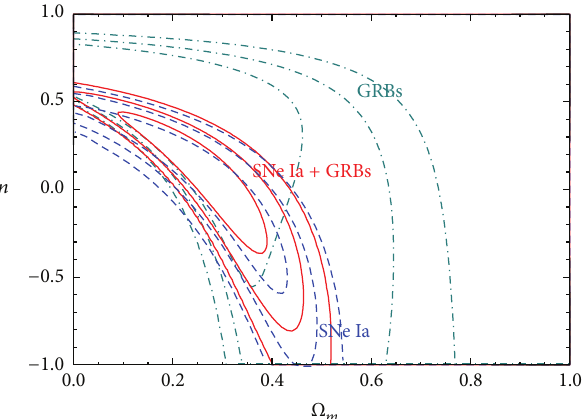
Figure 4: The contour confidence levels of (Ω 𝑚 ,𝑛) in the Cardassian expansion model from the data for 82 GRBs ( 𝑧 > 1.4 ) (dark cyan dash-dotted lines), 580 SNe Ia (blue dashed lines), and 82 GRBs + 580 SNe Ia (red solid lines), respectively. The contours correspond to 1, 2, and 3𝜎 confidence regions.